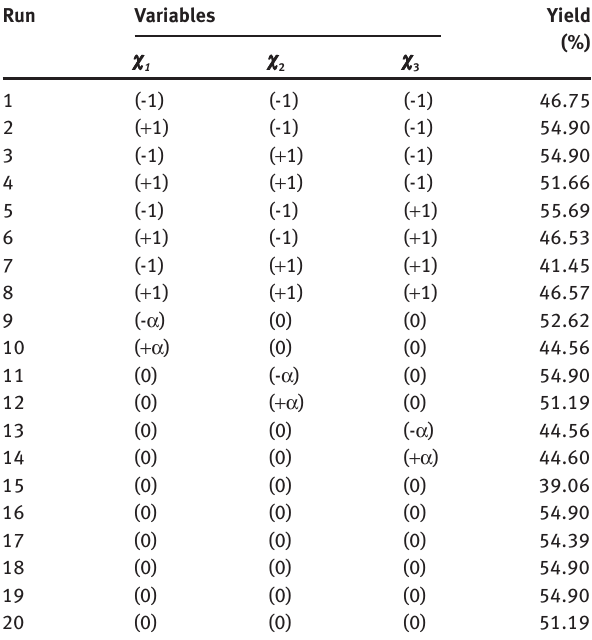
Table 2: Central composite design matrix with three independent variables and results.